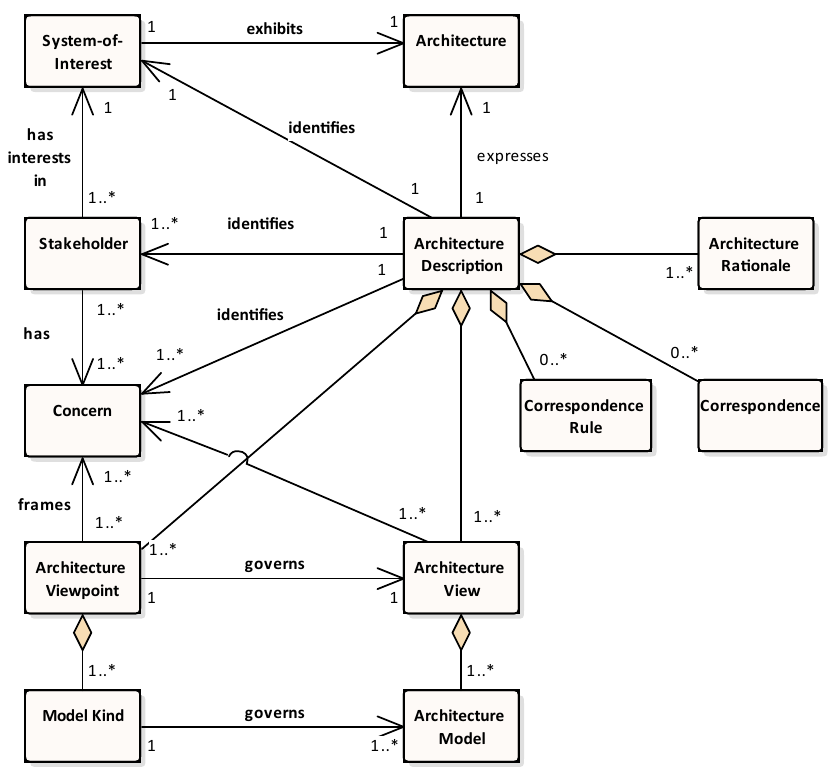
Figure 3. Conceptual model of an architecture description according to ISO 42010